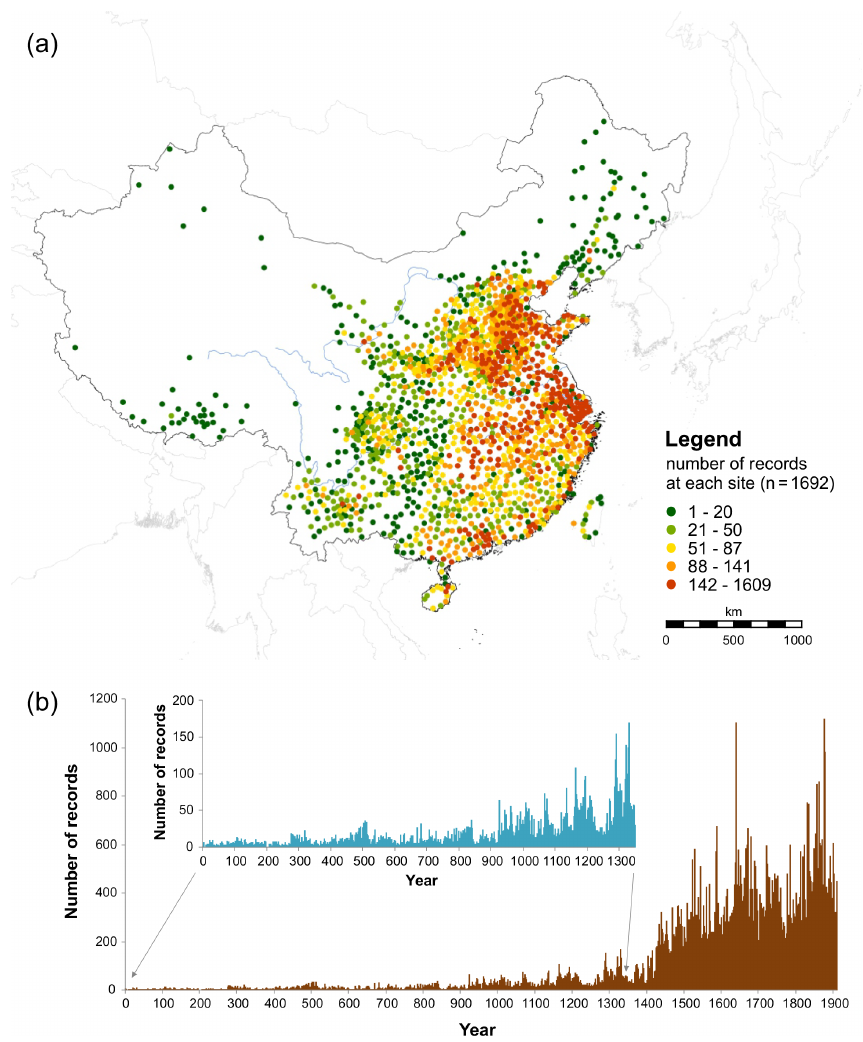
Figure 3. Numbers of historical documentary records in the REACHES database for China. (a) Spatial distribution of records at 1692 geographical sites across China. (b) Temporal evolution of the records in the database from 1 to 1911CE (brown series); the inset (blue series) shows the same data for 1 to 1350CE but with an expanded vertical